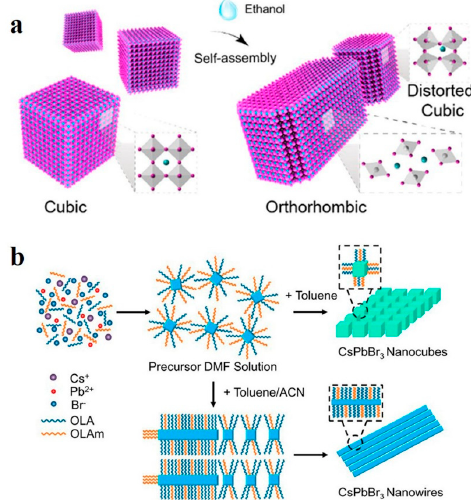
Figure 7. ( a ) Selfassembly mechanism of CsPbI 3 nanocubes into NWs. Reproduced with permission from reference [81]. Copyright 2018, American Chemical Society. ( b ) Formation mechanism of CsP ‐ bBr 3 NWs in toluene/ACN. Reproduced with permission from reference [82]. Copyright 2019, Amer ‐ ican Chemical